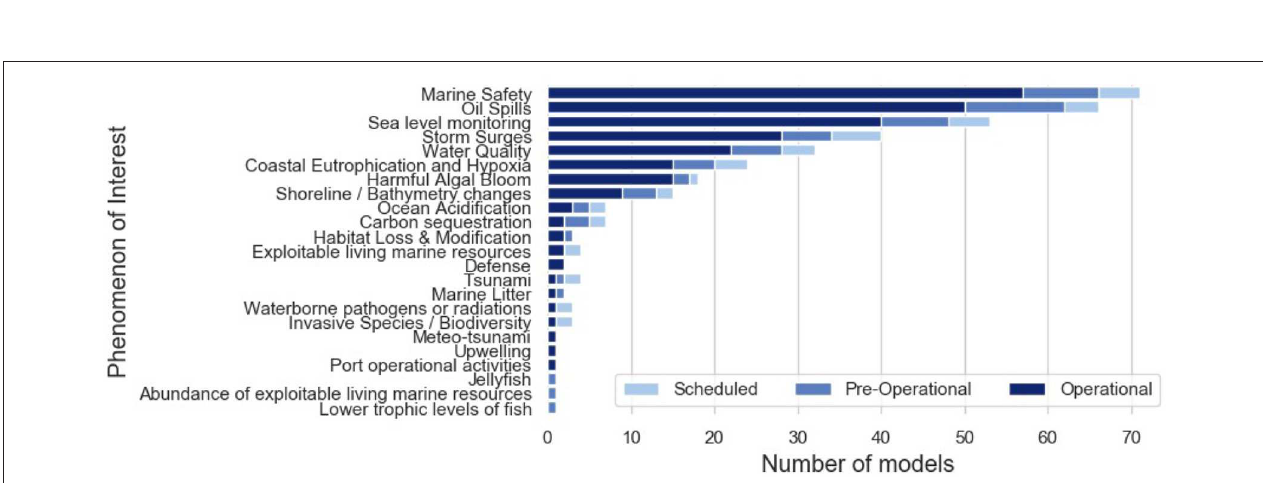
FIGURE 5 | Number of operational, pre-operational, and scheduled model implementations providing quantitative results for each Phenomena of Interest (POI).